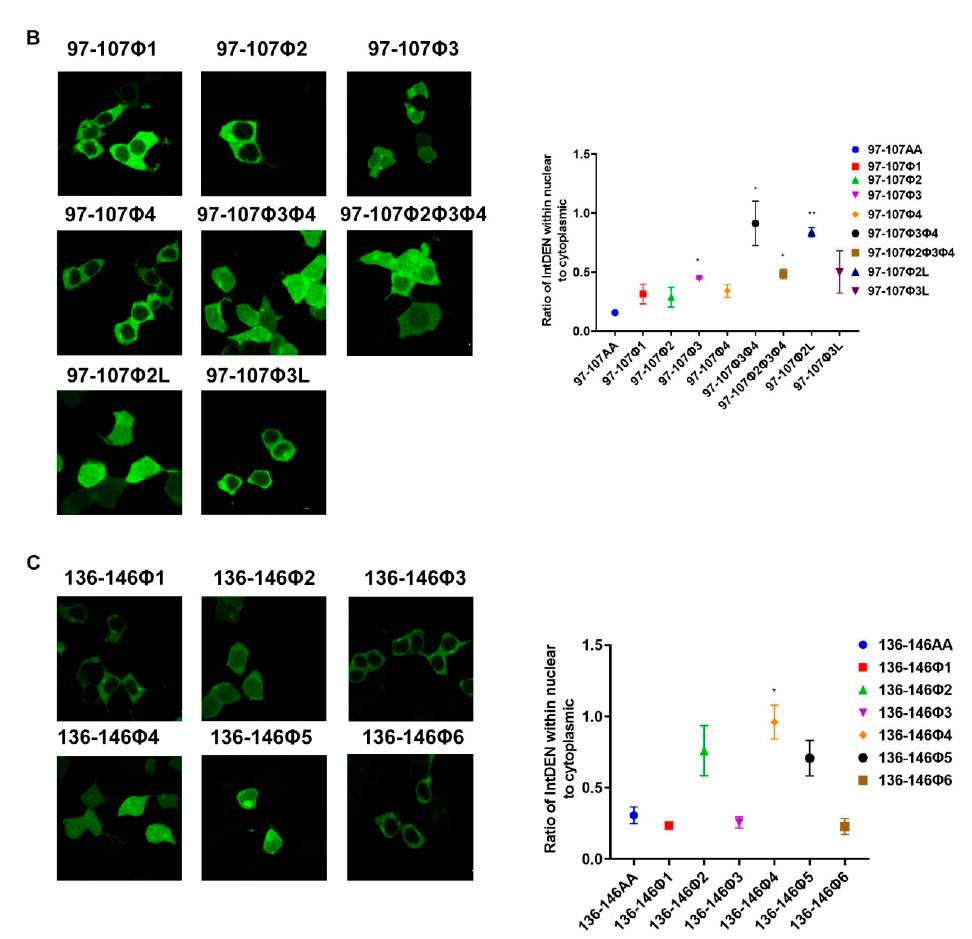
Figure 4. Identification of critical amino acid residues of NESs motifs mediating the nuclear export of eGFP fusion protein. ( A ) HEK293T cells growing on cover glass were transfected with pCAGGS encoding eGFP-NES (66–75aa) mutants (66–75aa Φ 1, 66–75aa Φ 2, 66–75aa Φ 3, 66–75aa Φ 4). ( B ) HEK293T cells were transfectedwithpCAGGSencodingeGFP-NES(97–107aa)mutants(97–107aa Φ 1, 97–107aa Φ 2, 97–107aa Φ 3, 97–107aa Φ 4, 97–107aa Φ 3 Φ 4, 97–107aa Φ 2 Φ 3 Φ 4, 97–107aa Φ 3L, 97–107aa Φ 2L). ( C ) HEK293T cells were transfected with pCAGGS encoding eGFP-NES (136–146aa) mutants (136–146aa Φ 1, 136-146aa Φ 2, 136–146aa Φ 3, 136–146aa Φ 4, 136–146aa Φ 5, 136–146aa Φ 6). Subcellular localization of eGFP fusion protein was examined via fluorescence microscopy 24 h post-transfection. Quantification of